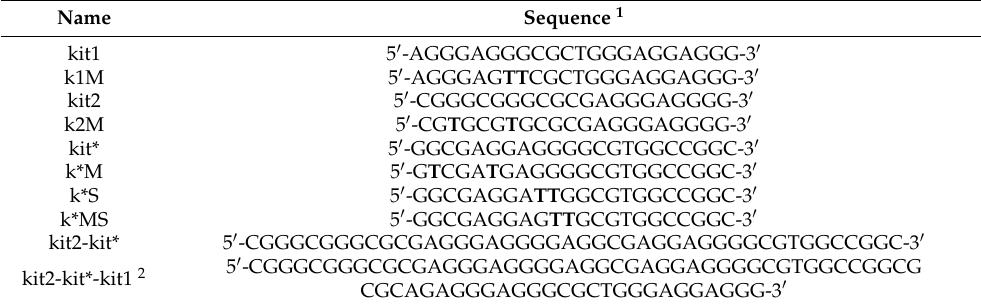
Table 1. Wild type (WT) sequences and related mutated sequences selected for transfection studies.